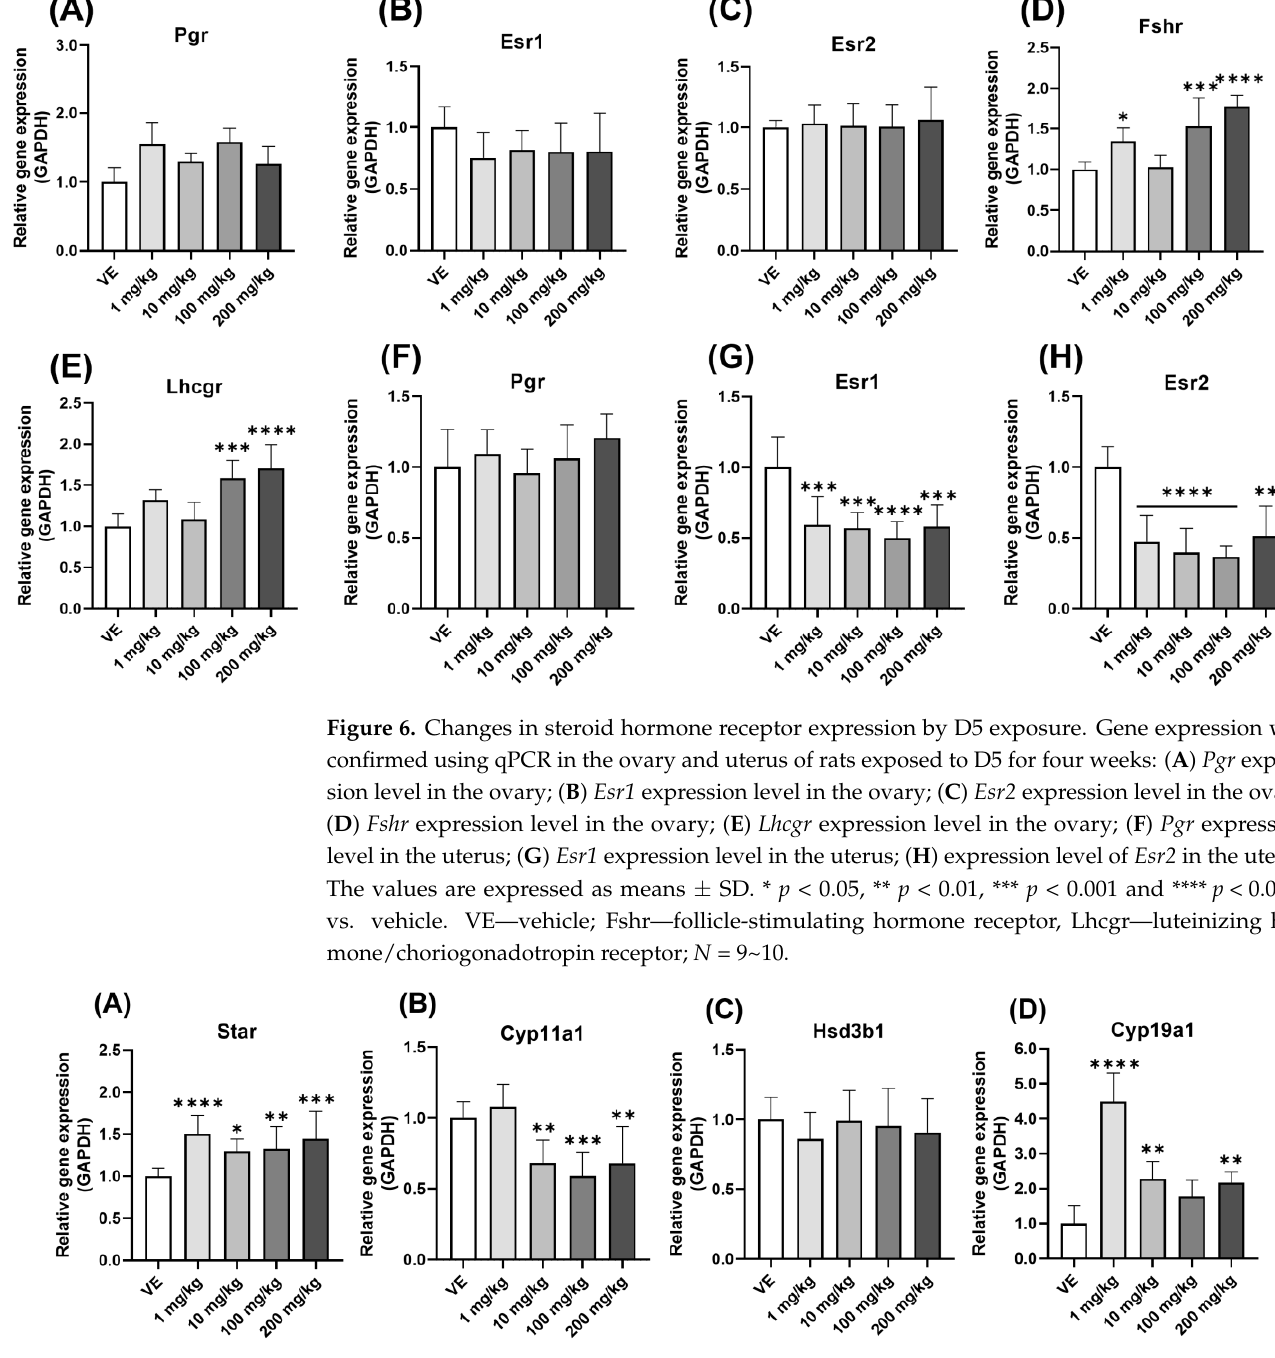
Figure 7. Changes in the expression level of ovary steroid hormone formation upon exposure to D5. Gene expression confirmed by qPCR in the ovary of rats exposed to D5 for four weeks: ( A ) Star expression level; ( B ) Cyp11a1 expression level; ( C ) Hsd3b1 expression level; ( D ) Cyp19a1 expression level. The values are expressed as means ± SD. * p < 0.05, ** p < 0.01, *** p < 0.001 and **** p < 0.0001 vs. vehicle. VE—vehicle, N = 9~10.